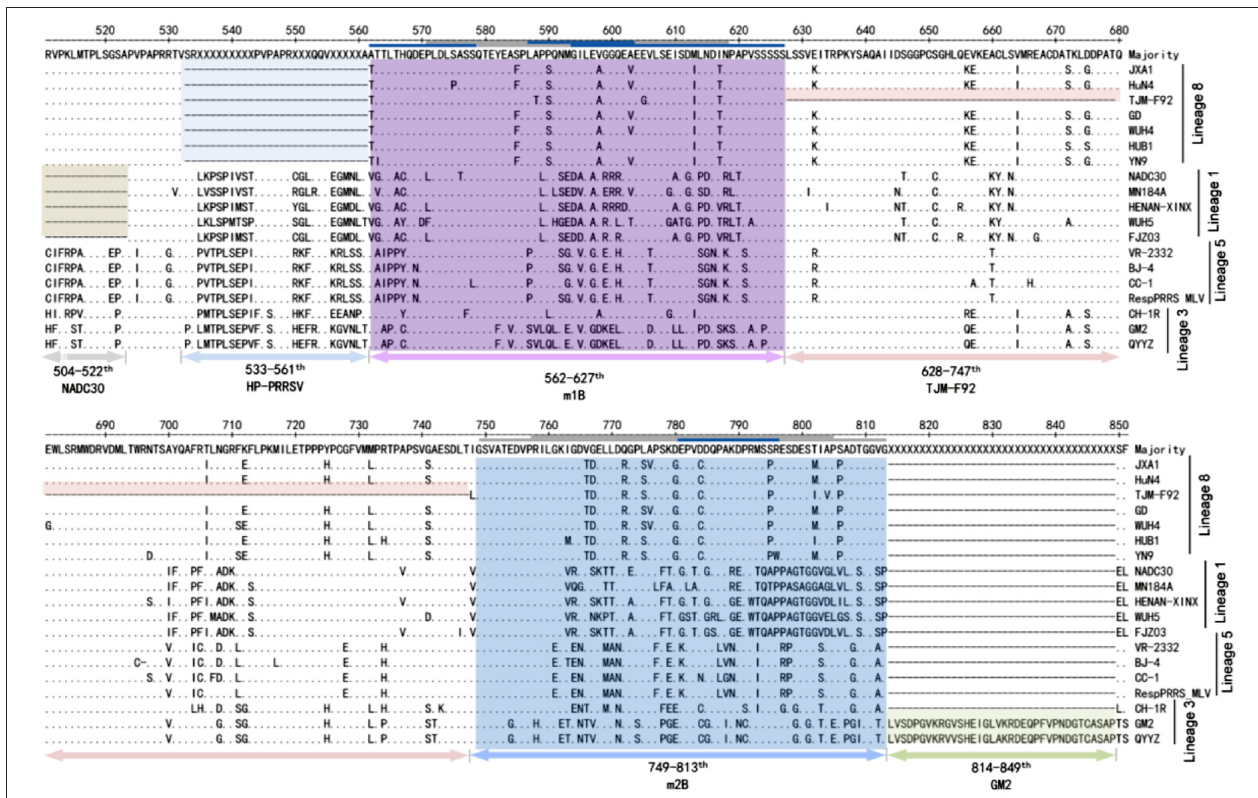
FIGURE 5 | Sequence analysis of m1B and m2B. Representative strains of current circulating PRRSVs or modified live vaccines (MLVs) are shown. The positions of indels in m1B and m2B are labeled below the sequences, whereas overlapping short peptides (m1B1–m1B7 and m2B1–m2B7) are labeled above the sequences. A blue line indicates reactivity between the short peptide and PRRSV-positive serum, whereas a gray line denotes no reactivity.